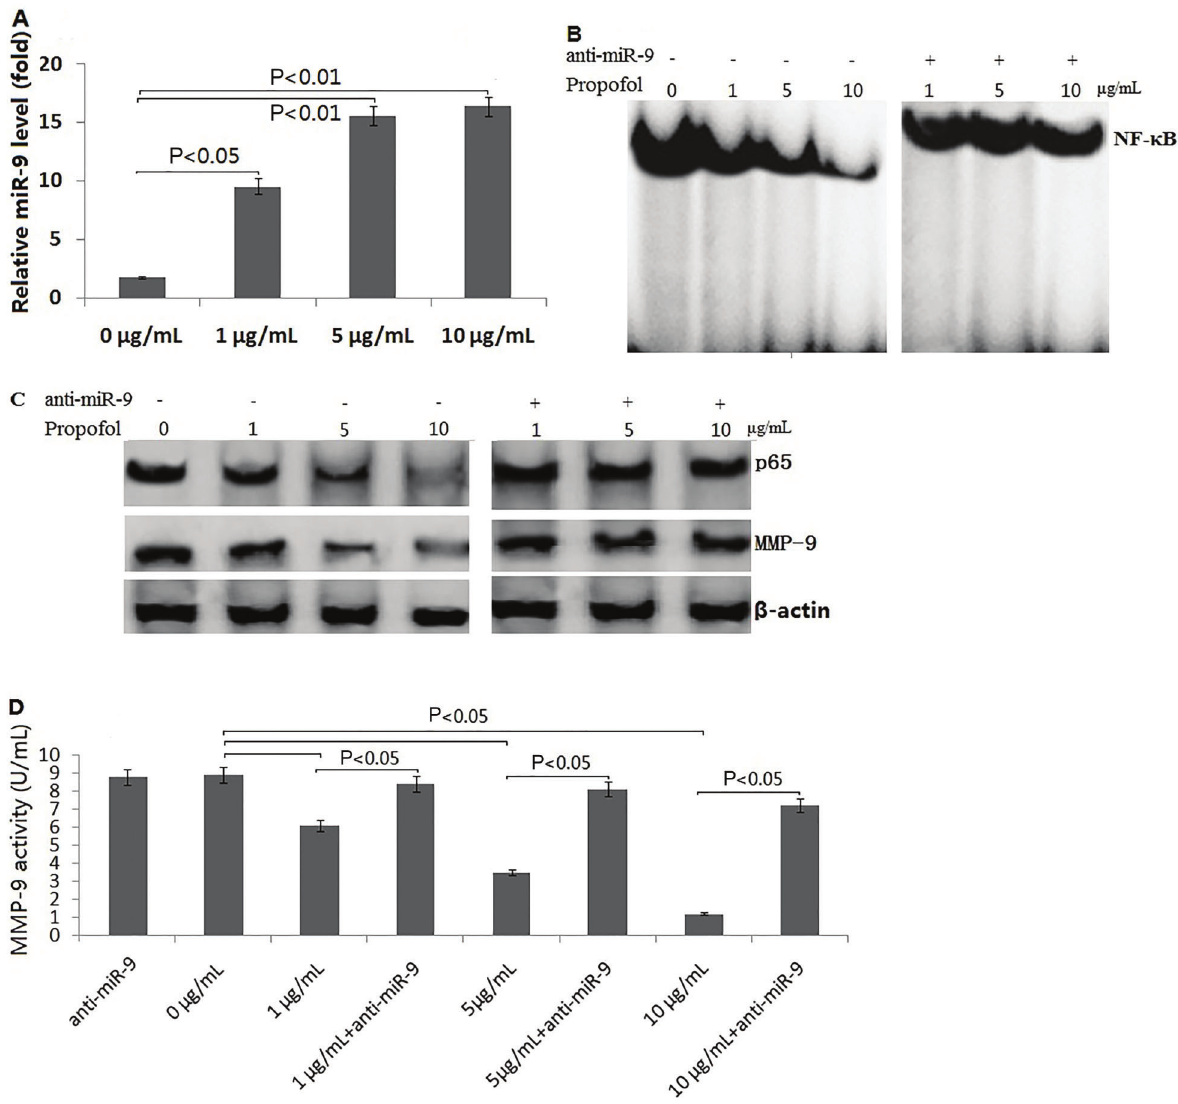
Figure 2. Propofol regulated miR-9-dependent NF- k B and MMP-9 expression. ES-2 cells were treated with propofol (1, 5, and 10 m g/mL) for 24 h, or for 6 h, then treated with anti-miR-9 for 24 h. A , miR-9 expression was detected by qRT-PCR assay. B , NF- k B activity was detected by EMSA. C , p65 and MMP-9 protein expression was detected by western blot assay. D , MMP-9 activity was detected by ELISA. The t -test was used for statistical